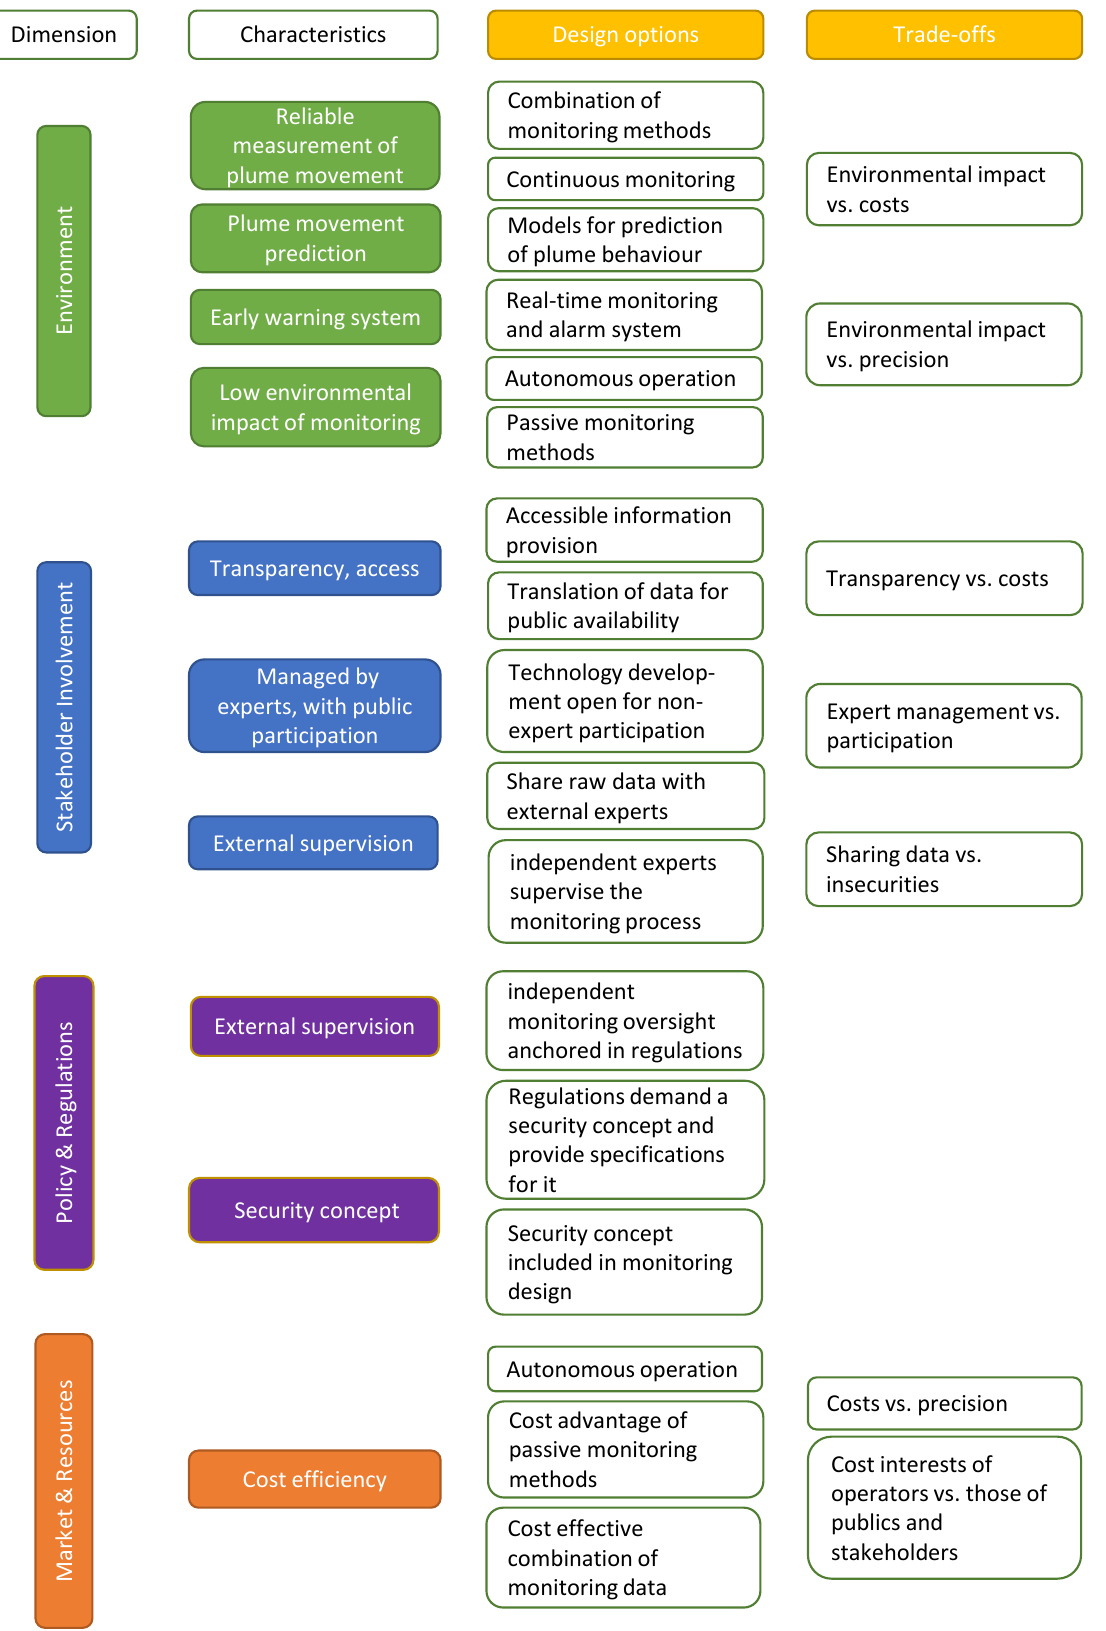
Figure 3. Overview of design options and trade-offs